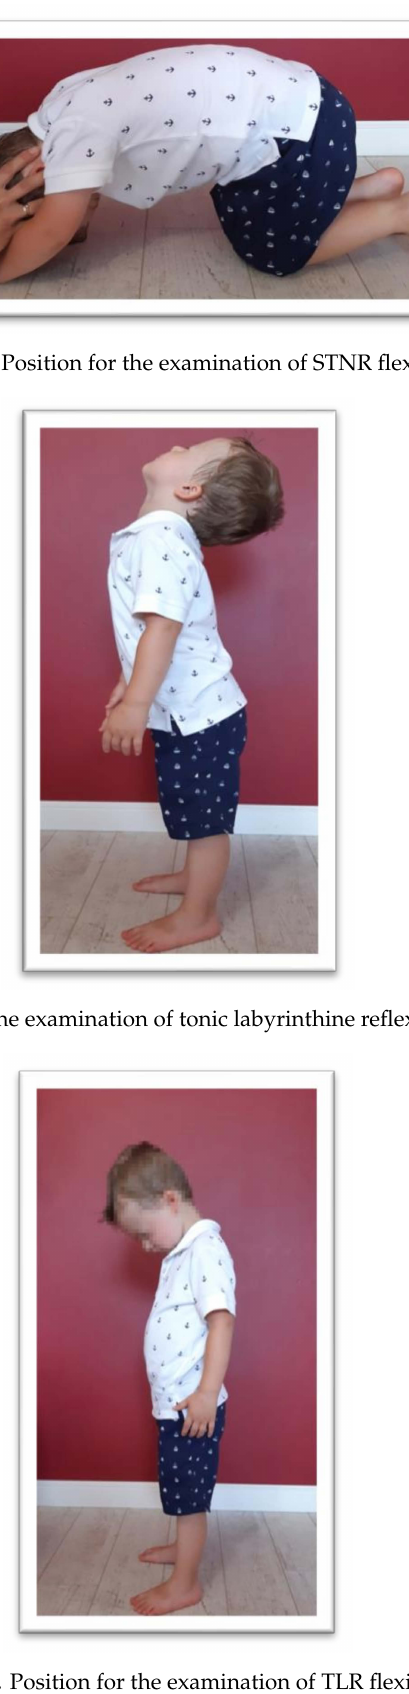
Figure 5. Position for the examination of TLR